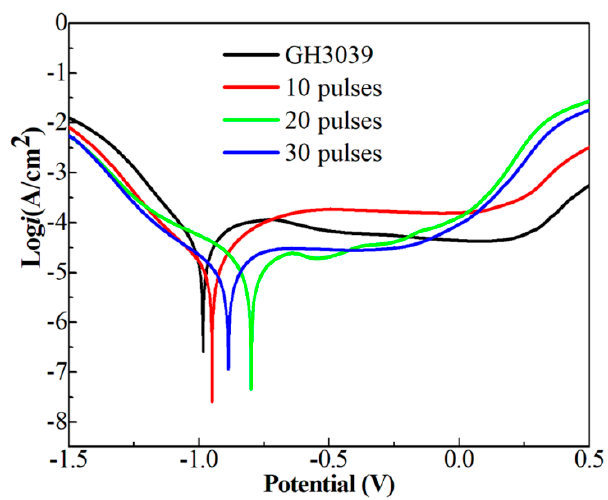
Figure 10. The polarization curves of the Ni-Nb coating before and after HCPEB irradiation. Table 1. Icorr and Ecorr of the Ni-Nb coating before and after HCPEB irradiation.